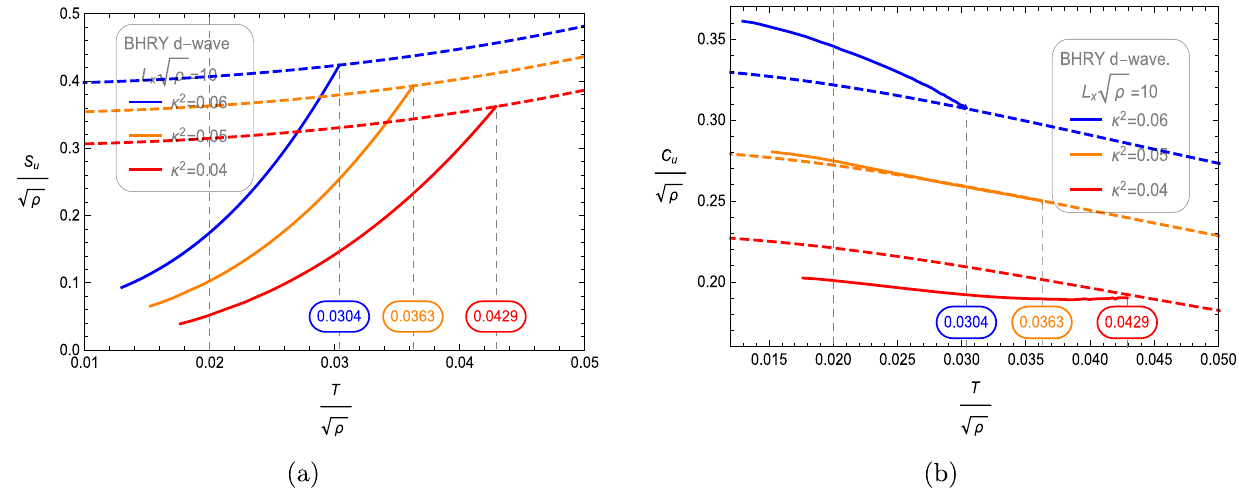
√ ρ for the BHRY d-wave superconductor with a fixed subregion L